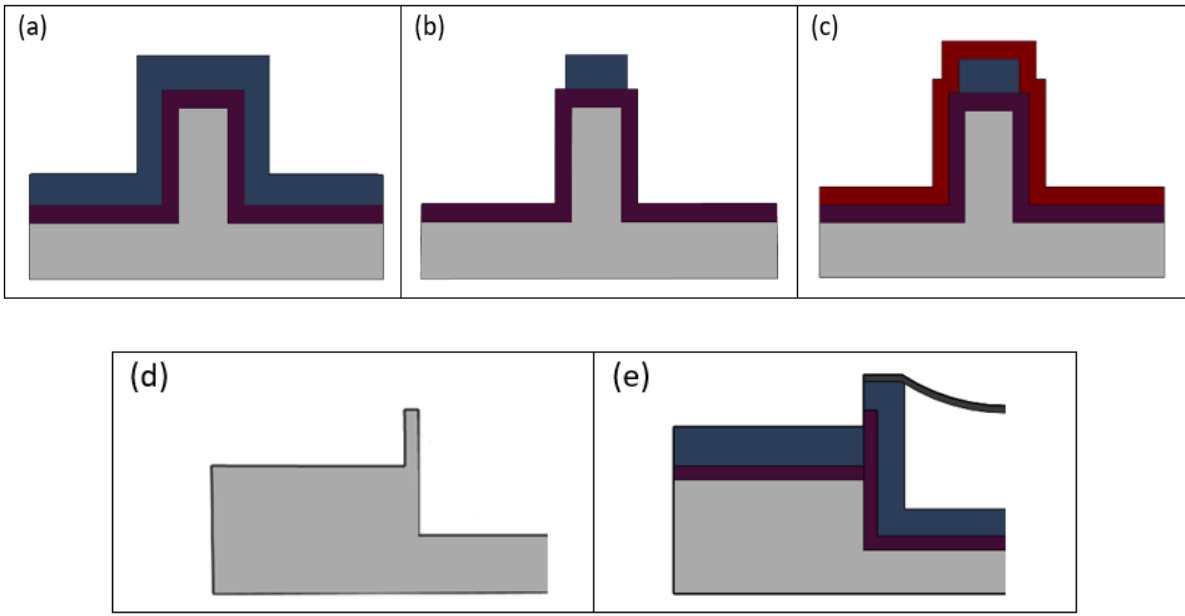
Figure 3. Solid-core ridge waveguide fabrication. ( a ) A pedestal is etched into silicon and then converted into silicon dioxide by way of thermal oxidation. High index PECVD silicon dioxide is grown over the thermal silicon dioxide. ( b ) High index silicon dioxide is patterned and etched to form the waveguide core. ( c ) Low index PECVD silicon dioxide is grown over the high index silicon dioxide as a cladding layer. ( d ) SC to LC intersection after etching in silicon and before thermal oxidation. Intersection side wall must be thin enough that complete thermal oxidation from silicon to silicon dioxide occurs. ( e ) Complete thermal oxidation of interface. Ridge waveguide can transmit light into the LC through interface.